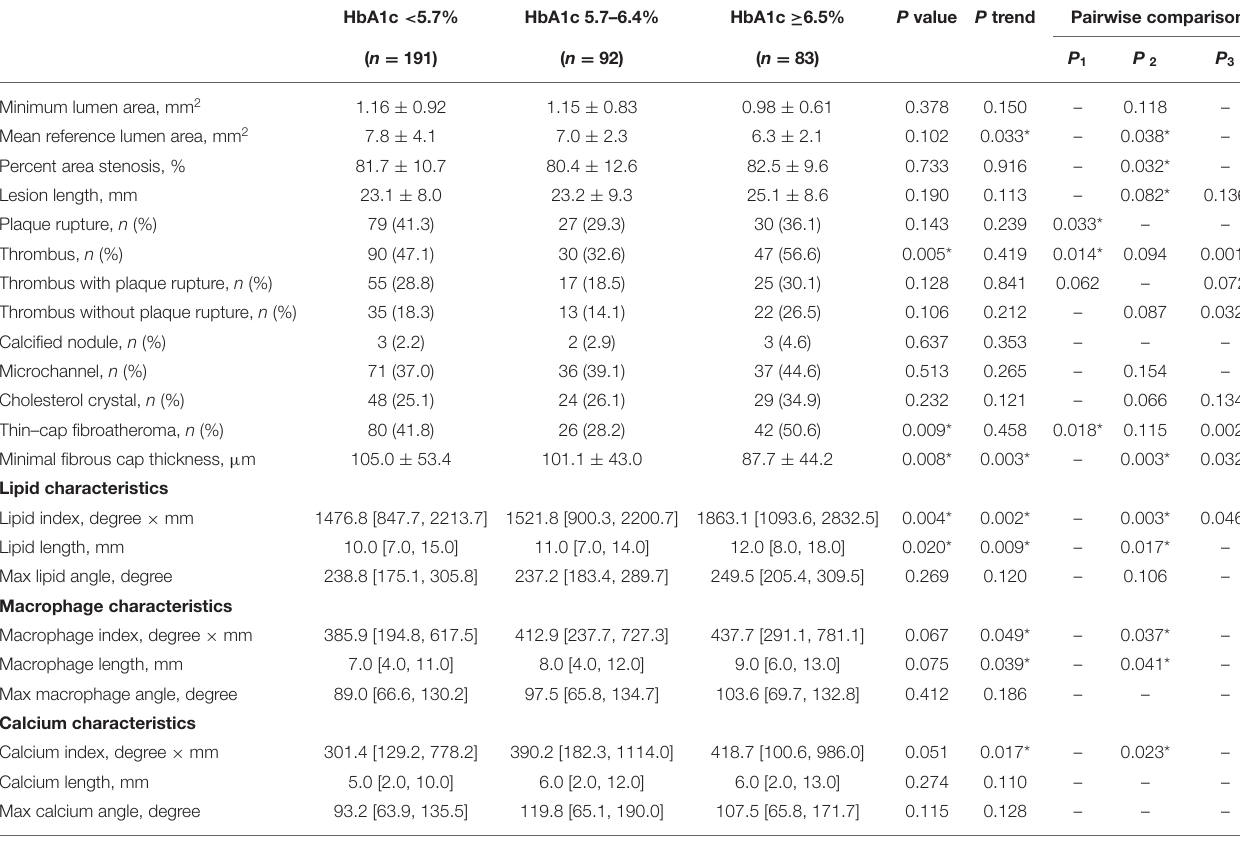
TABLE 2 | Vulnerability features of the culprit vessel by OCT assessment according to HbA1c